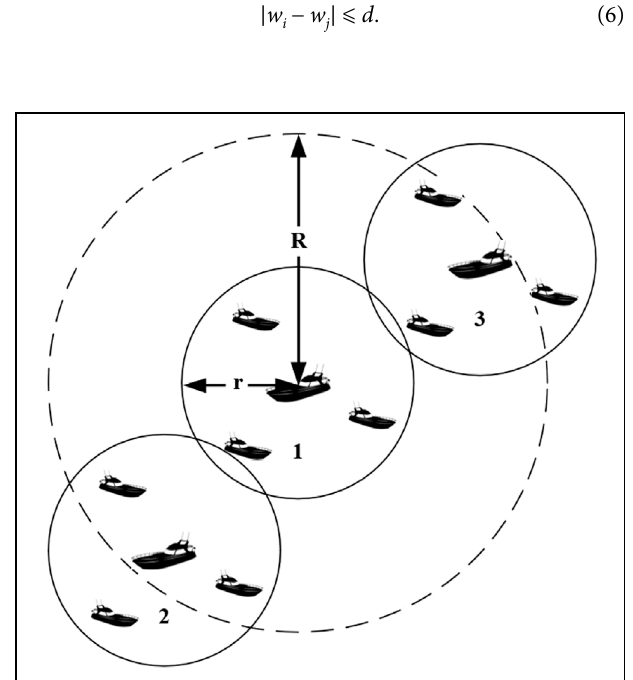
FIGURE 3 | Communication model of USV ad hoc